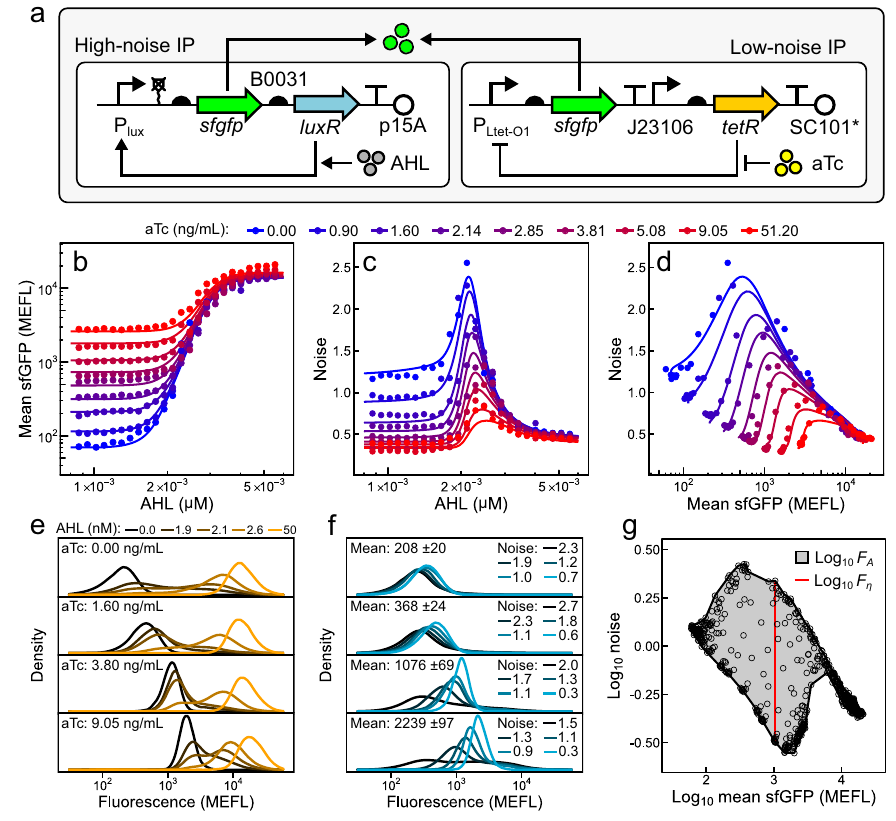
Fig. 3 Independent control of mean and noise by summation of gene expression from IP h /IP l . a Plasmids encoding IP h and IP l are co-transformed into E. coli and induced with AHL and aTc, respectively. sfGFP from each IP sum inside cells. Steady-state AHL-mean ( b ), AHL-noise ( c ), and mean-noise ( d ) transfer functions of cells harboring plasmids in a with exposure to combinations of AHL and aTc. Mean and noise values (points) and model fi ts (lines) shown are a subset (9 out of 25 aTc concentrations) selected for evenly spaced visualization. Selected fl uorescence density estimates of cell populations induced with AHL and aTc ( e ) over a wide range of inducer concentrations, or f to a wide range of noise at virtually the same mean. g Concave hull (black line) of the complete mean-noise pointset (circles) used to calculate dynamic area and dynamic noise. Points and density estimates are single replicates collected from three separate experiments performed on 3 separate